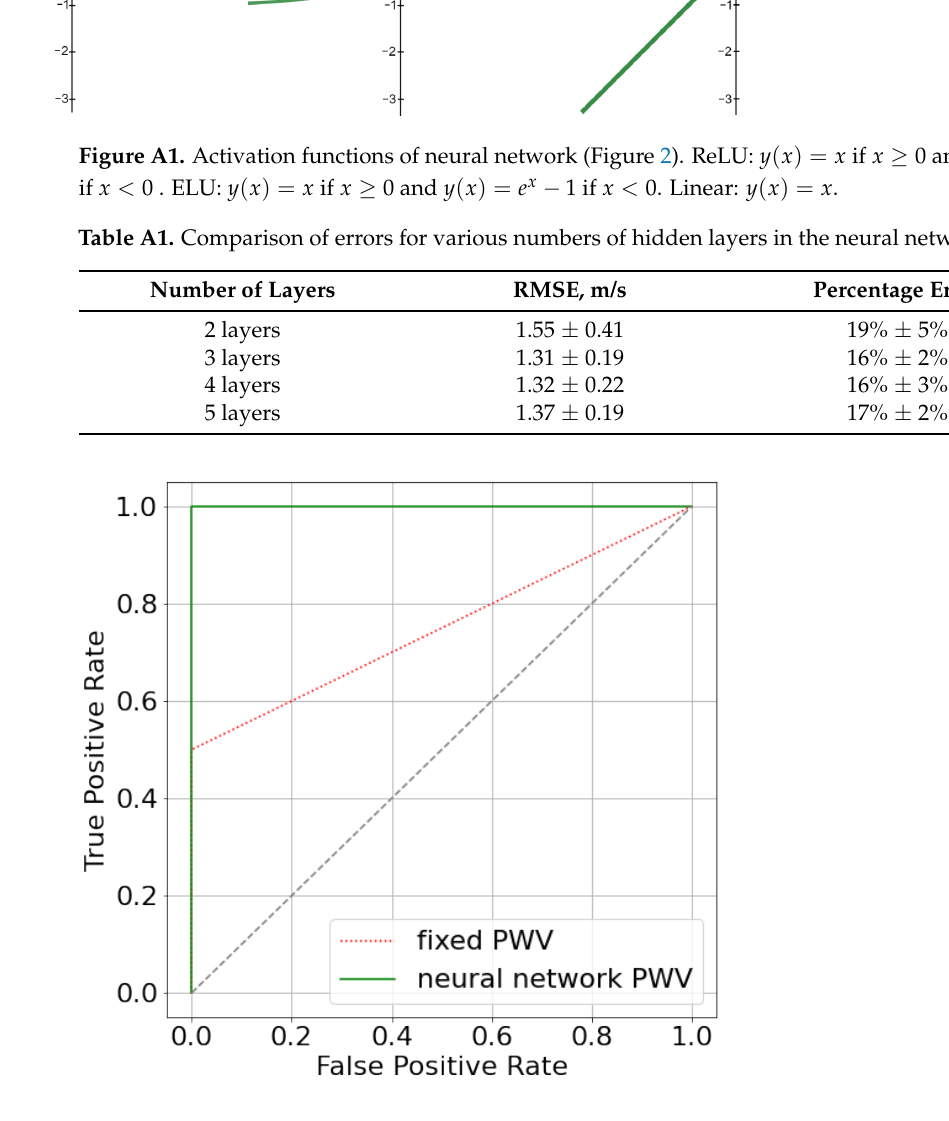
Figure A2. ROC-curves for two approaches that estimate FFR: utilizing fixed AoPWV 7.5 m/s and AoPWV from the neural network. In both cases, stenosis is considered to be significant if FFR <